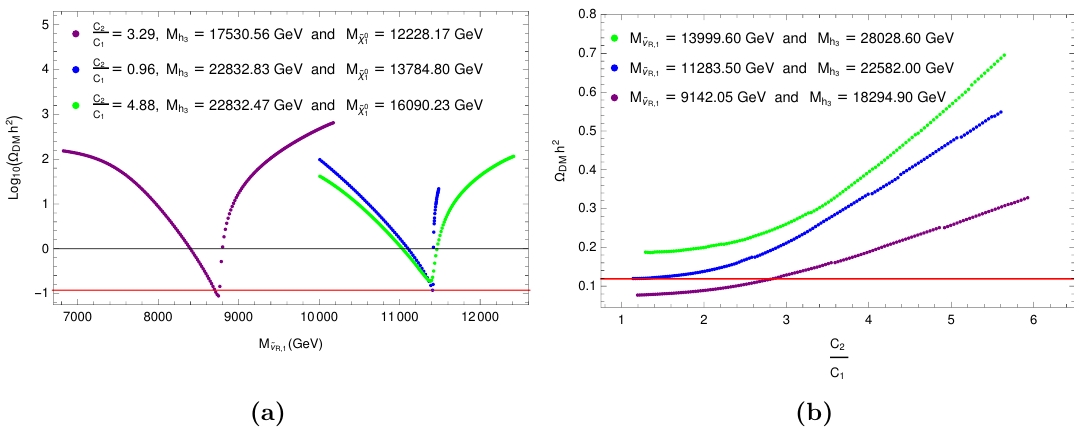
Figure 3. Relic density as a function of M ~ (cid:23) R; 1 (left) and its dependence on the ratio of couplings C 2 (right) for di(cid:11)erent singlet Higgs masses. The red lines correspond to the limits on the dark C 1 matter abundance obtained by the Planck Collaboration, (cid:10) DM h 2 = 0 : 1188 0 : 0010. (cid:6) relic density because it increases the normalization of the annihilation cross section.